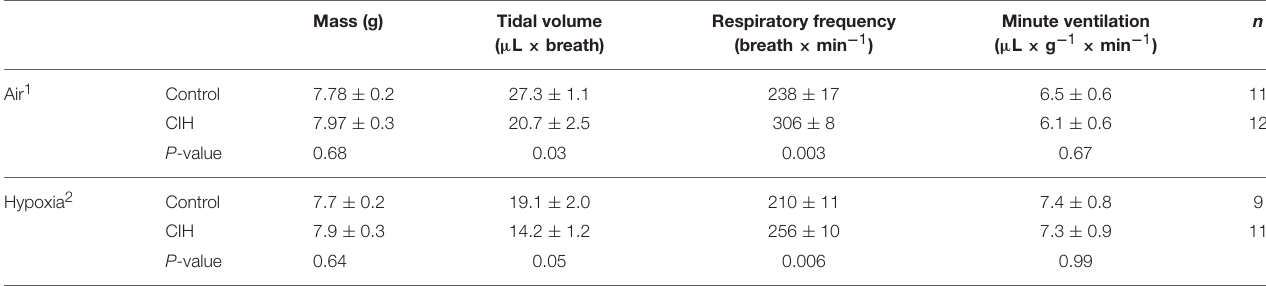
TABLE 2 | Respiratory metrics recorded while breathing air or